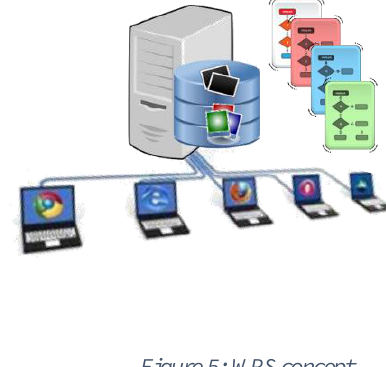
Figure 5: WPS concept